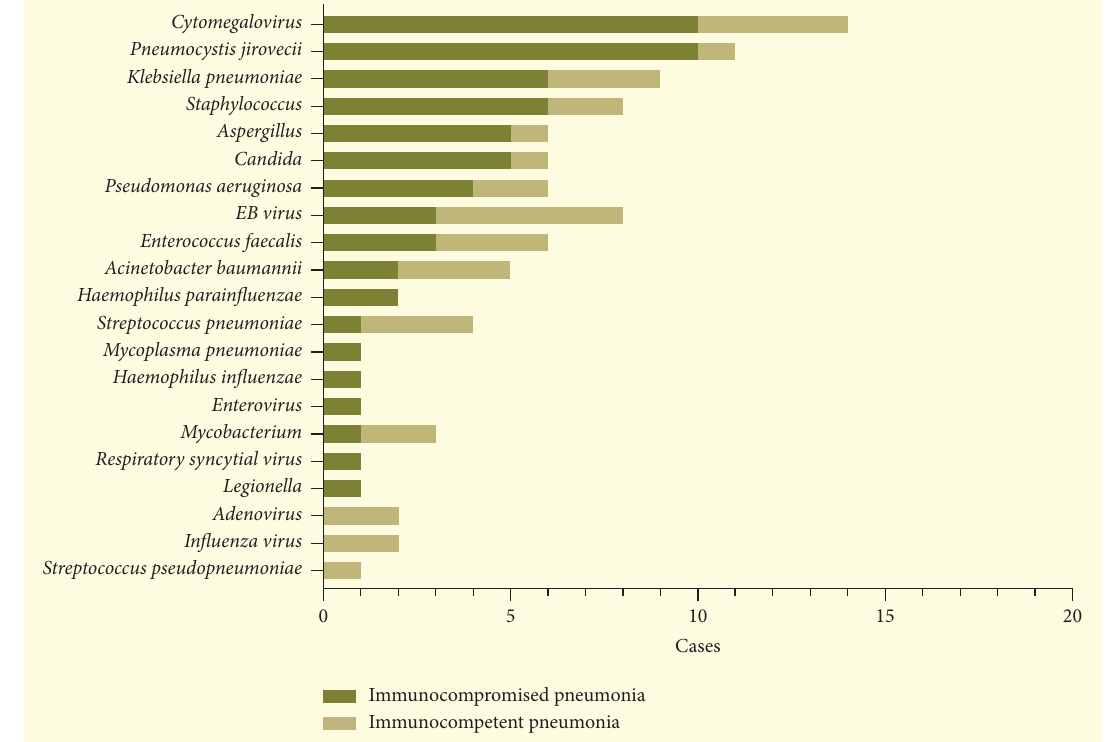
Figure 3: Te distribution of pathogens in immunocompromised patients and immunocompetent patients with pneumonia.